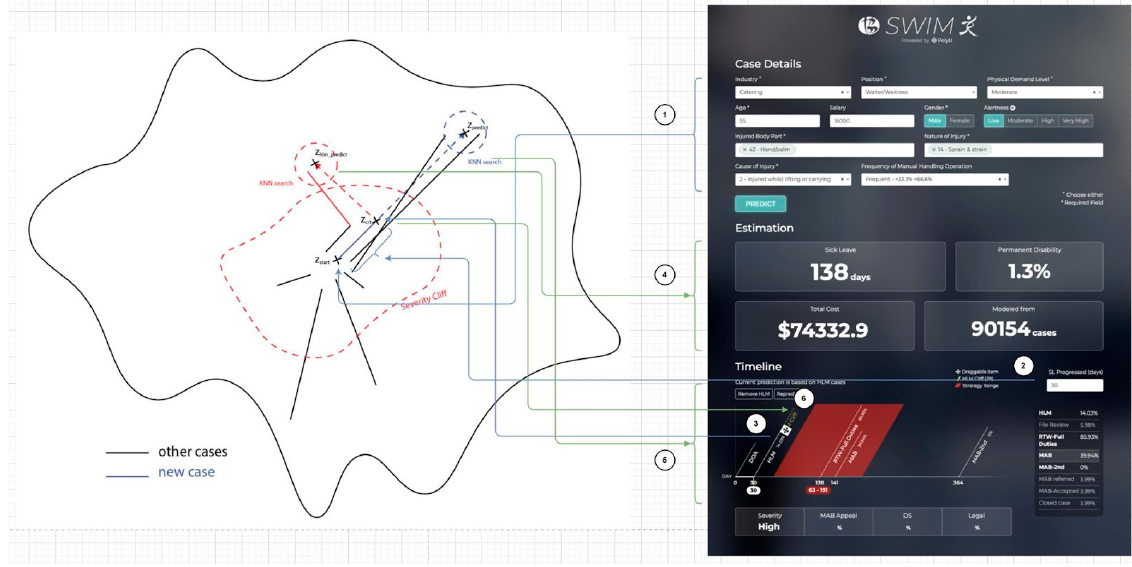
Figure 6. Sample screen of SWIM 1.0.